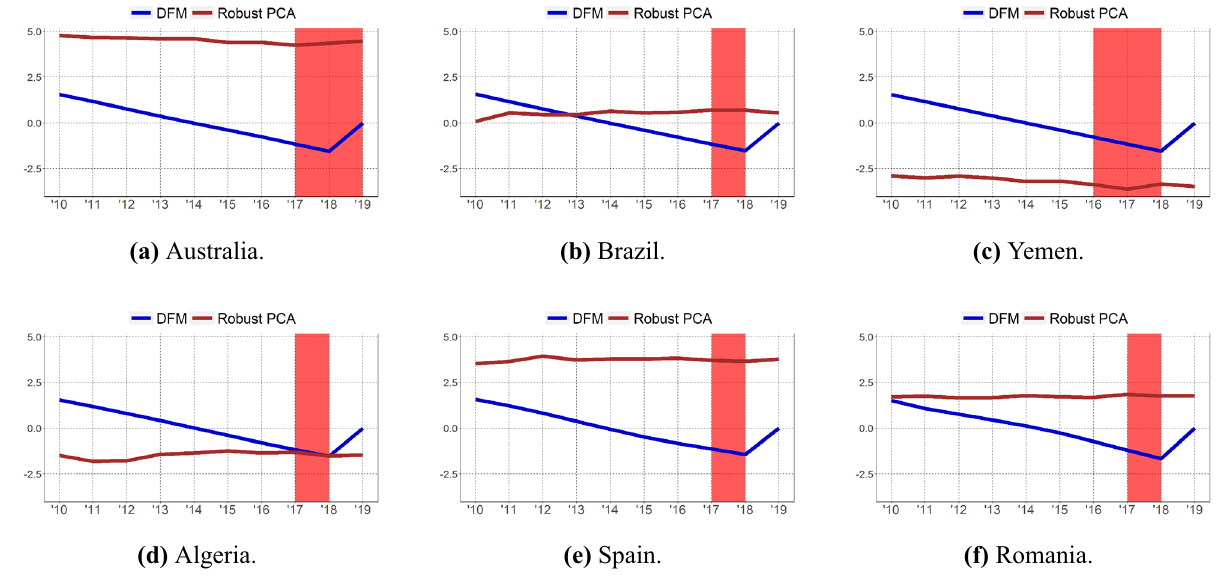
Figure 2. Index evolution over years for some countries. Disease outbreaks are shaded in red. Figure is generated with R software 56